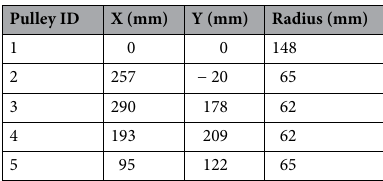
Table 1. Layout of tested belt drive system.